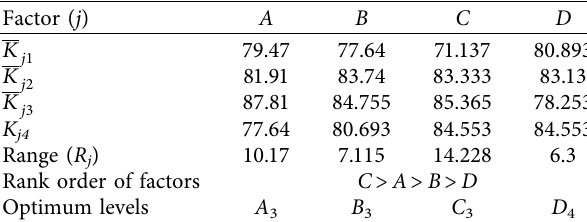
Table 4: Range analysis results of relative wear rates. Factor ( j ) A B C